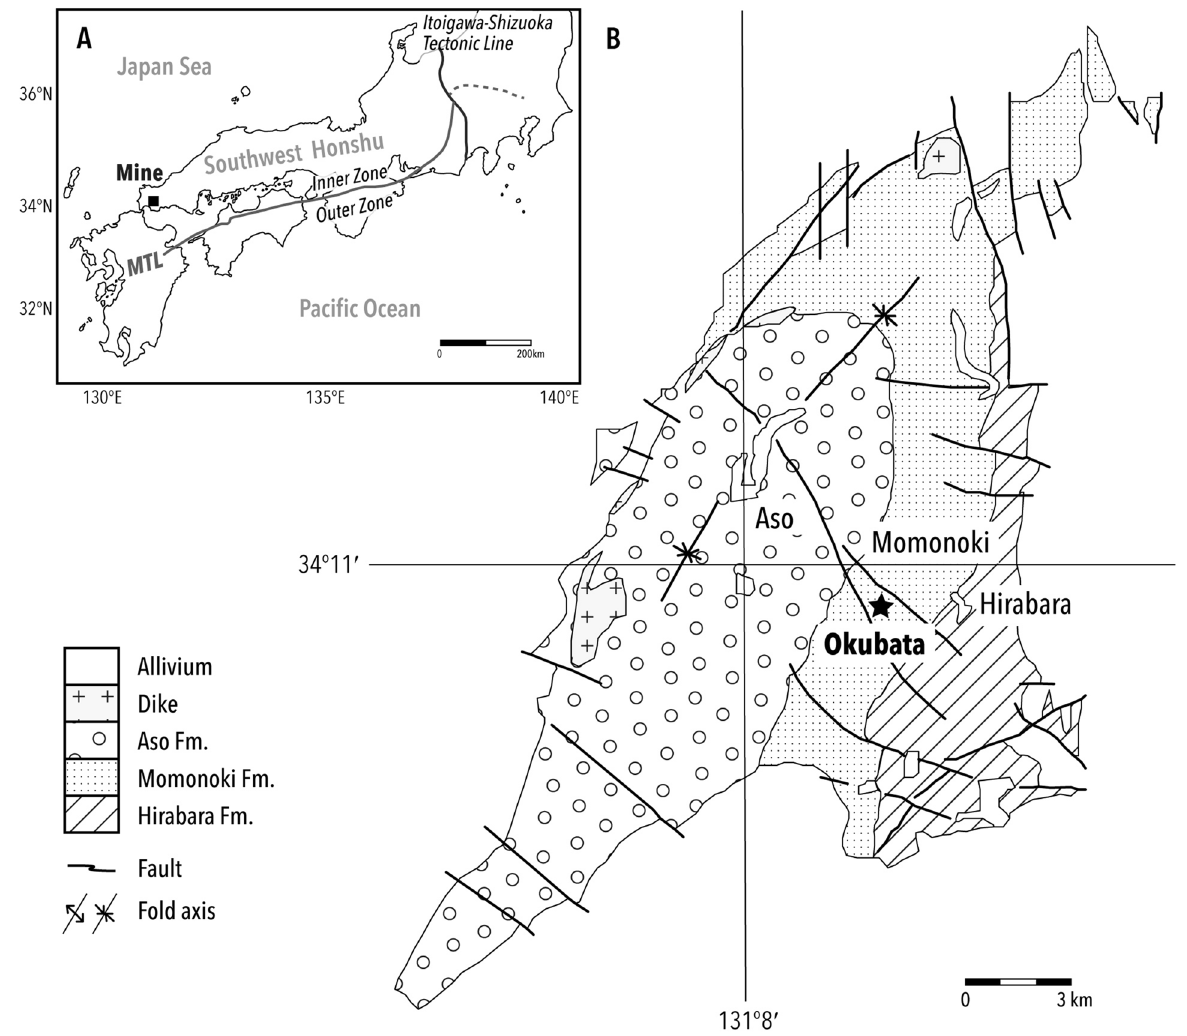
Figure 1. Study site location and geological map. ( A ) Map showing the fossil site, Mine, Yamaguchi, in southwest Honshu, Japan. Mine is located in the Inner Zone, the region formed by complex faulting along the Median Tectonic Line (MTL) and separated from the Outer Zone (southern side). ( B ) Geological map of the Mine Group, slightly modified from previous studies 38,39 . The star denotes the fossil locality,